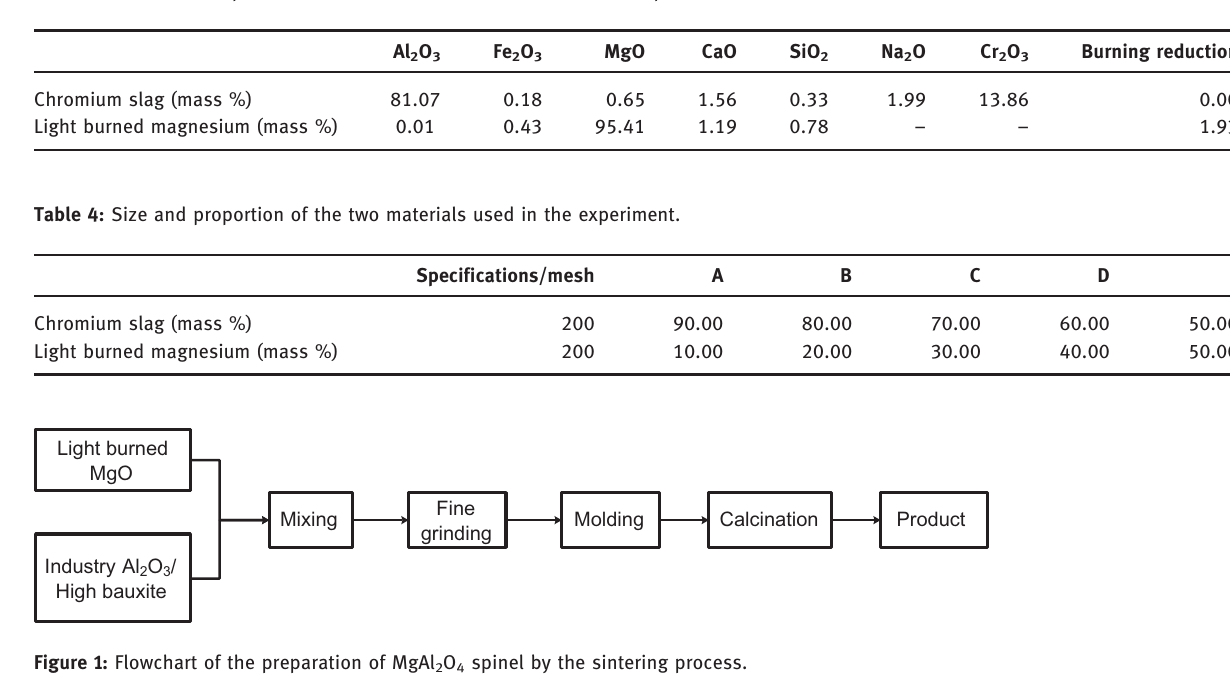
Table 3: Chemical composition of the two raw materials used in the experiment.